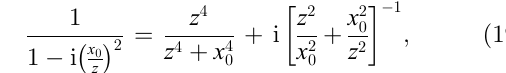
Figure 2. Ratio of the stiffnesses per unit area of fl owing and resting air s 0 r = s 0 over x = a R (circular) or x = a L (quadratic), a plus marker